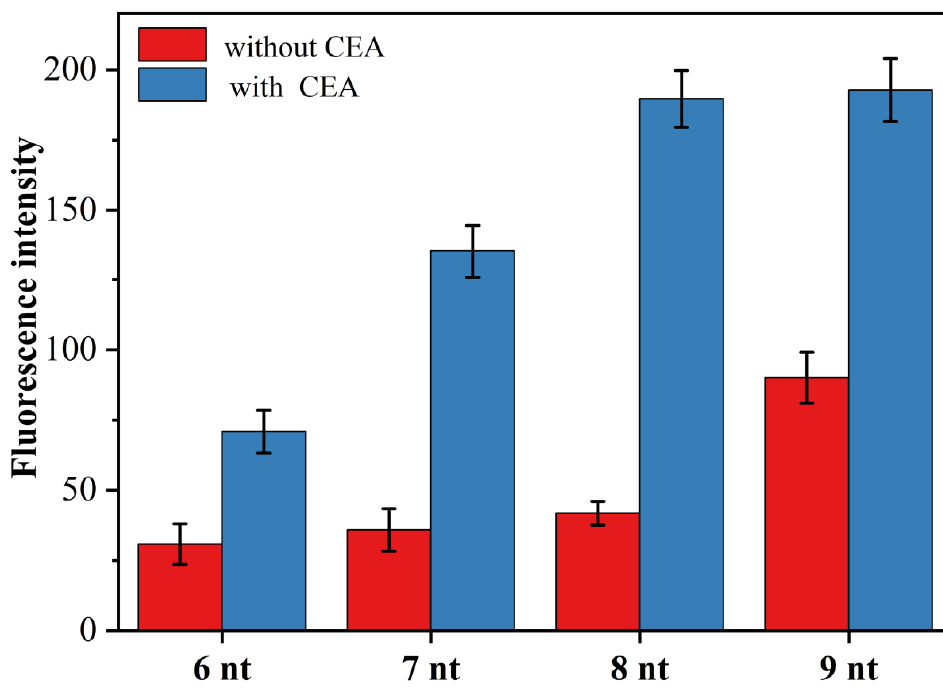
Figure 4. Effect of primer chain length on the fluorescence intensity of CEA (1.0 pg/mL) assay, (6 nt: primer-1; 7 nt: primer-2; 8 nt: primer-3; 9 nt: primer-4).